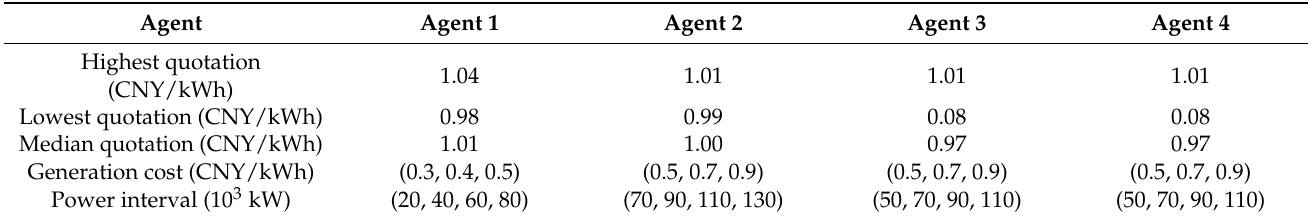
Table 3. Parameters of each power